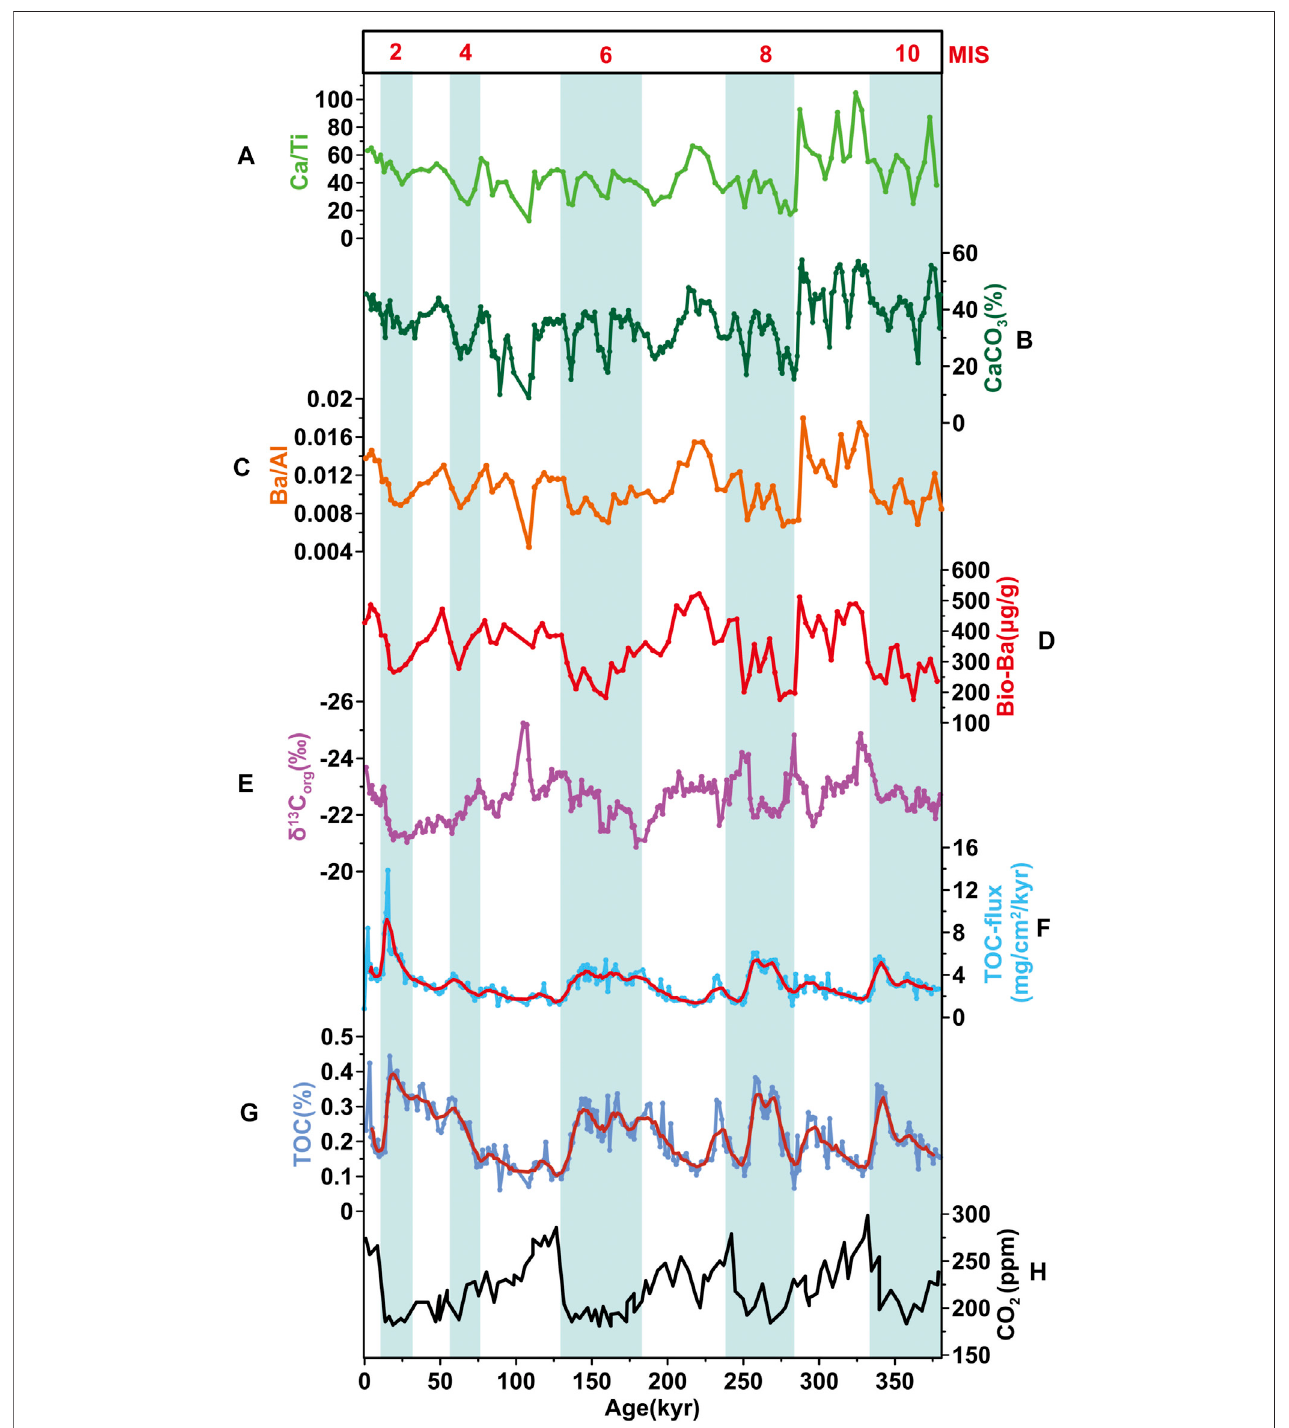
FIGURE 3 | Variation trends of organic carbon fl ux and its source contribution in core St10-PC. (A) Biogenic elements of Ca/Ti ratio, (B) biogenic calcium (CaCO 3 ) contents, (C) biogenicelementsofBa/Alratio, (D) biogenicbarium(Ba bio )contents, (E) δ 13 C org , (F) TOC fl uxeswitha5-pointrunningaverage(redline), (G) TOCcontents with a 5-point running average (red line), (H) atmospheric CO 2 concentrations (Lüthi et al., 2008); blue shadow, glacial periods. Original data of OC contents and the δ 13 C org were initially from Zhang et al.